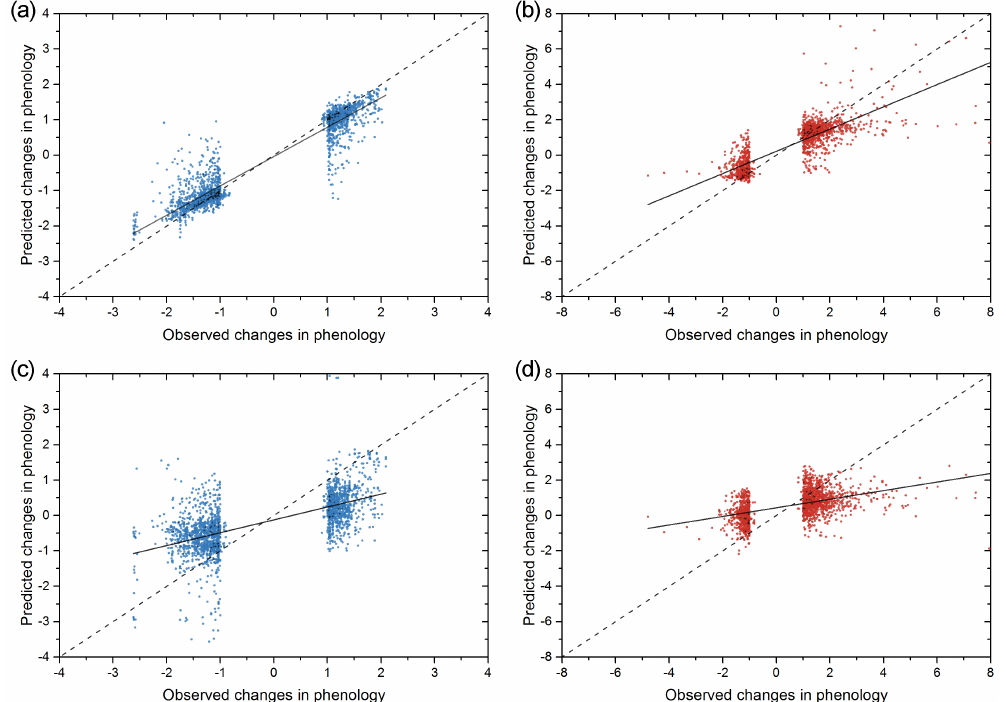
Figure 6. Scatterplots between observed anomalies in LSP and the predictions calculated using a selection of weather predictors (see Figs. 2 and 3). Plots for spring phenology are shown on the left panel (blue; a, c ) and autumn on the right (red; b, d ). Random-forest (RF) predictions are given in the upper panel (a, b) and those of the linear regression in the bottom (c, d) panel. The dashed lines represent an exact 1:1 relationship (expected fitting); the solid lines show a linear regression of these data. The explained variances (percentage R 2 ) and RMSE values are 90% and 0.43 (spring RF model), 68% and 0.92 (autumn RF model), 39% and 1.04 (spring linear model), and 25% 1.40 (autumn linear